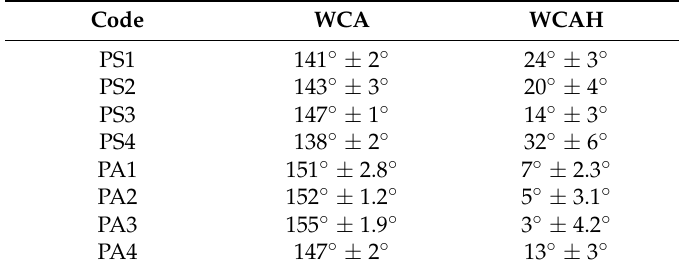
Table 3. WCA and CAH of the prepared PS and PS/Al 2 O 3 nanocomposite coatings.